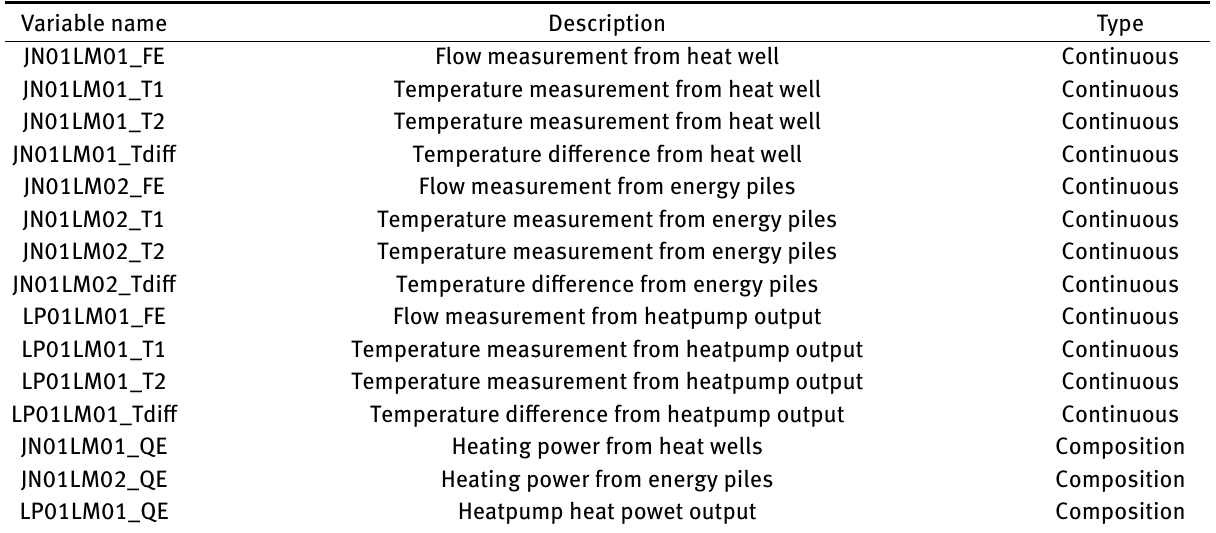
Table 1: Variable description for analytics